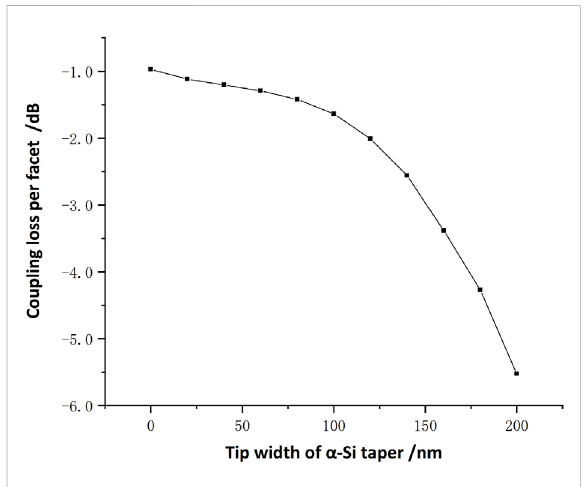
FIGURE 4 Coupling loss per fact vs.. tip width of α -Si nano taper.